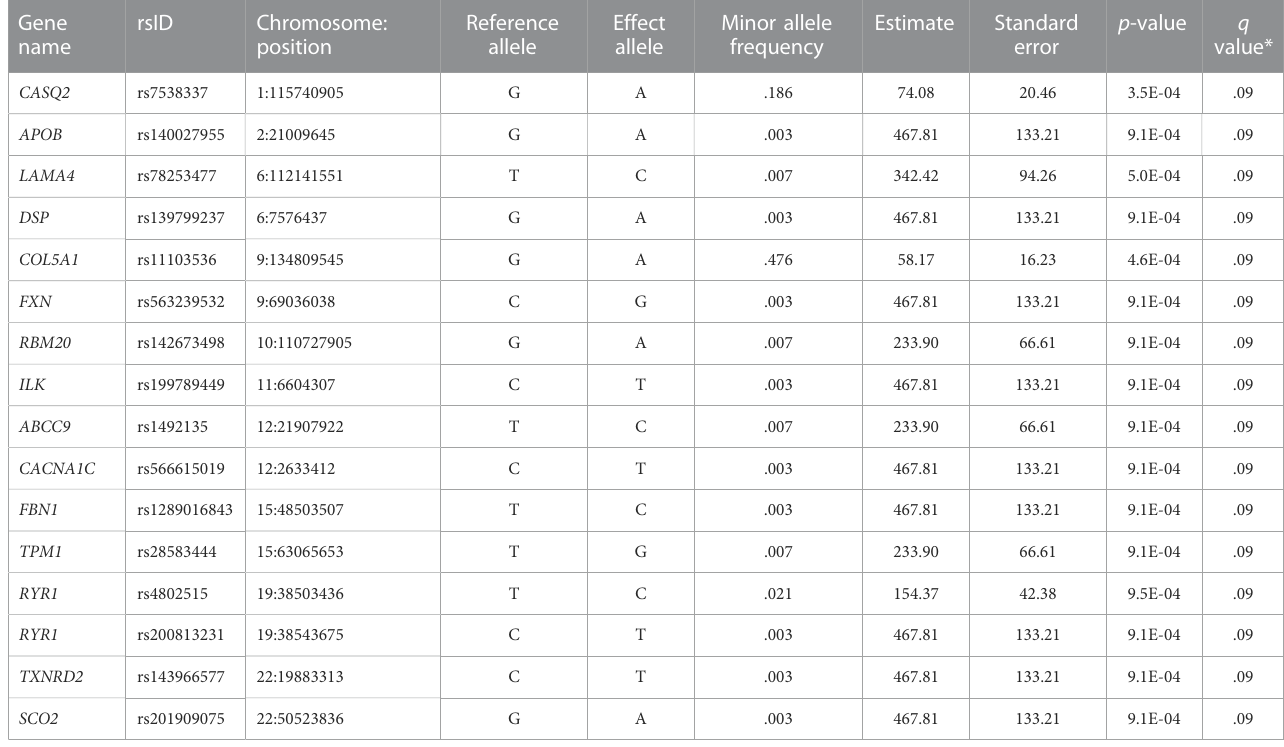
TABLE 2 Minimal p - and q -values in the single-variant analysis for the study